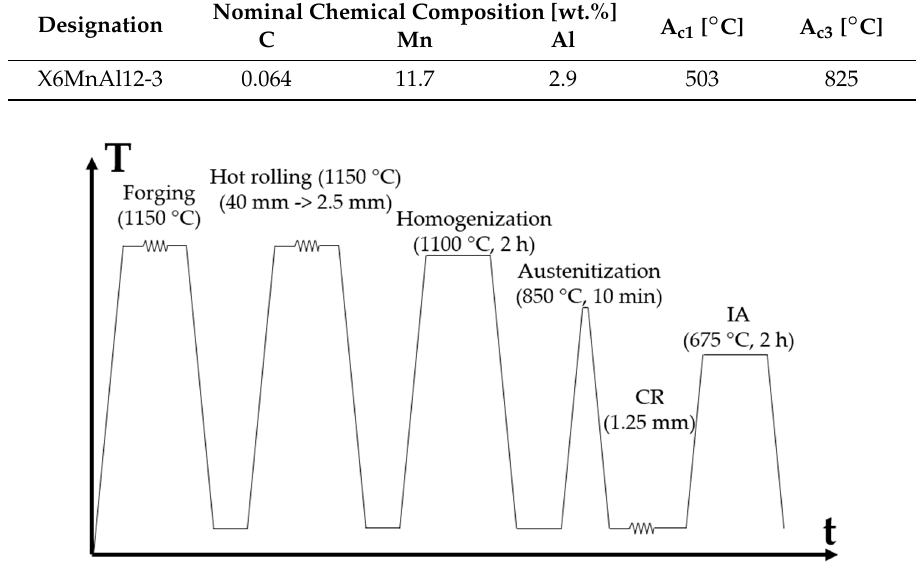
Figure 1. The processing route for the X6MnAl12-3 MMnS.